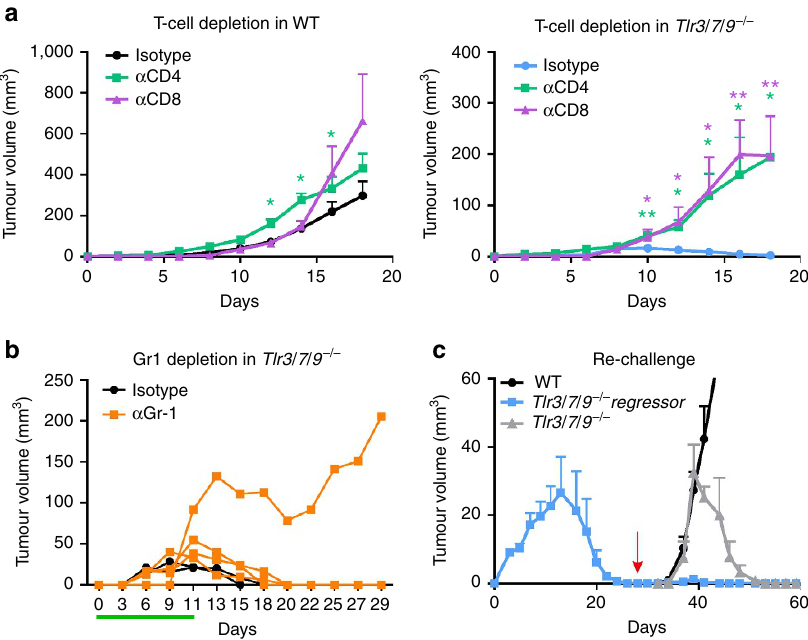
Figure 6 | T-cell-dependent tumour rejection in Tlr3/7/9 (cid:2) / (cid:2) mice. ( a ) Depleting antibodies against CD4 and CD8 were injected into 12- to 17-week-old C57BL/6 WTand Tlr3/7/9 (cid:2) / (cid:2) mice. Control mice were treated with appropriate isotype. Tumour growth was measured every other day. Mean ± s.e.m. of four to eight mice per group. Results were considered significant at * P r 0.05 and ** P r 0.005 ( t -test). ( b ) To deplete myeloid regulatory cells, treatment of 11- to 17-week-old C57BL/6 Tlr3/7/9 (cid:2) / (cid:2) mice with the a Gr-1 antibody started before tumour cell injection and was continued throughout the whole experiment ( n ¼ 4). The control group was treated with isotype antibodies ( n ¼ 2). Depletion was monitored in the peripheral blood using flow cytometry and is indicated by the green line. One representative experiment out of two is shown. ( c ) Tumour cells (0.5 (cid:3) 10 6 ) were injected s.c. into the right flank of Tlr3/7/9 (cid:2) / (cid:2) mice ( Tlr3/7/9 (cid:2) / (cid:2) regressor, blue). After tumour rejection (red arrow), the same mice were injected on the opposite flank with the same number of tumour cells. Naive Tlr3/7/9 (cid:2) / (cid:2) (grey) and C57BL/6 WTmice (black) were also injected and served as controls. At the time of rechallenge, mice were 24–26 weeks old. Tumour size was measured every other day. The mean tumour volume ± s.e.m. of three to five mice per group is